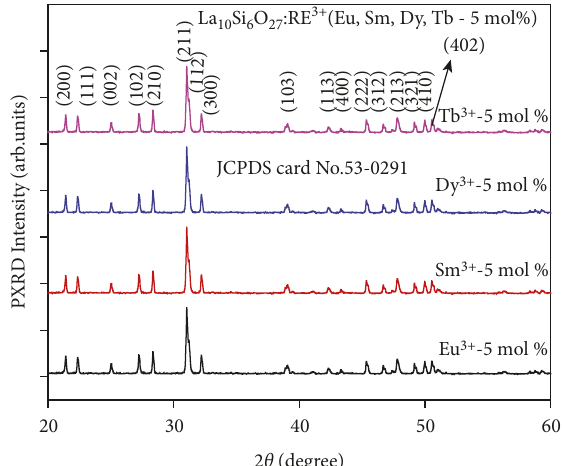
Figure 2: FTIR spectra of La 3+ (Eu, Sm, Dy, and Tb 10 Si 6 O 27 :RE -5 mol %) 3+ (5mol%) 10 Si 6 O 27 :RE